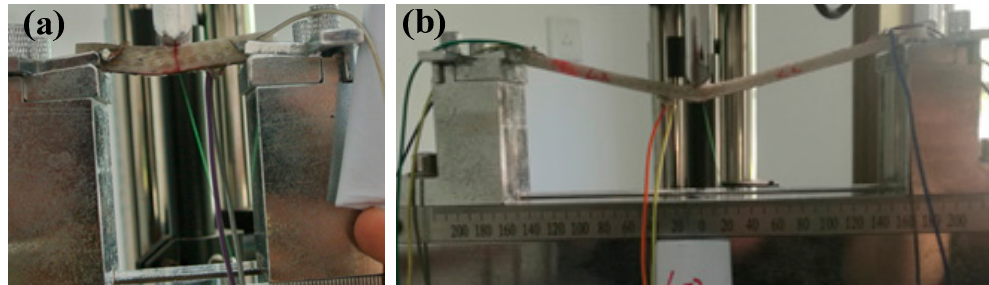
Figure 6. Experimental setup of the experiments with simultaneously resistance recording: ( a ) short beam shear test; ( b ) three-point-bending test.